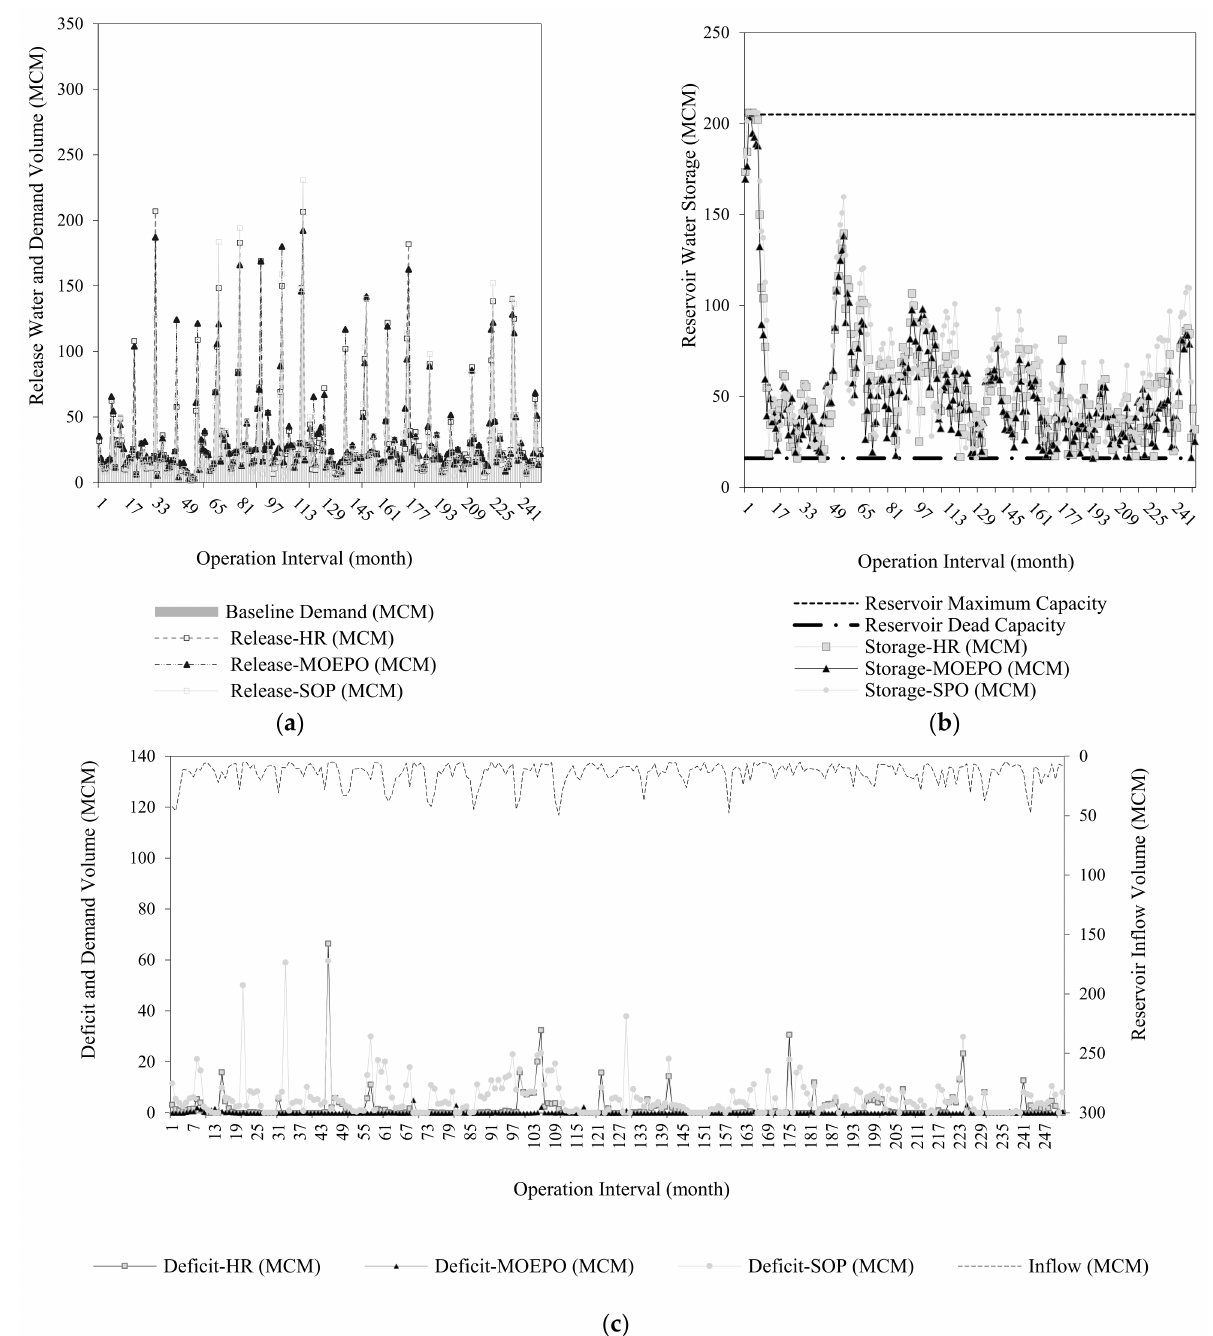
Figure 11. Comparison of: ( a ) Released volume; ( b ) Storage volume; ( c ) Deficit volume, corresponding to the third